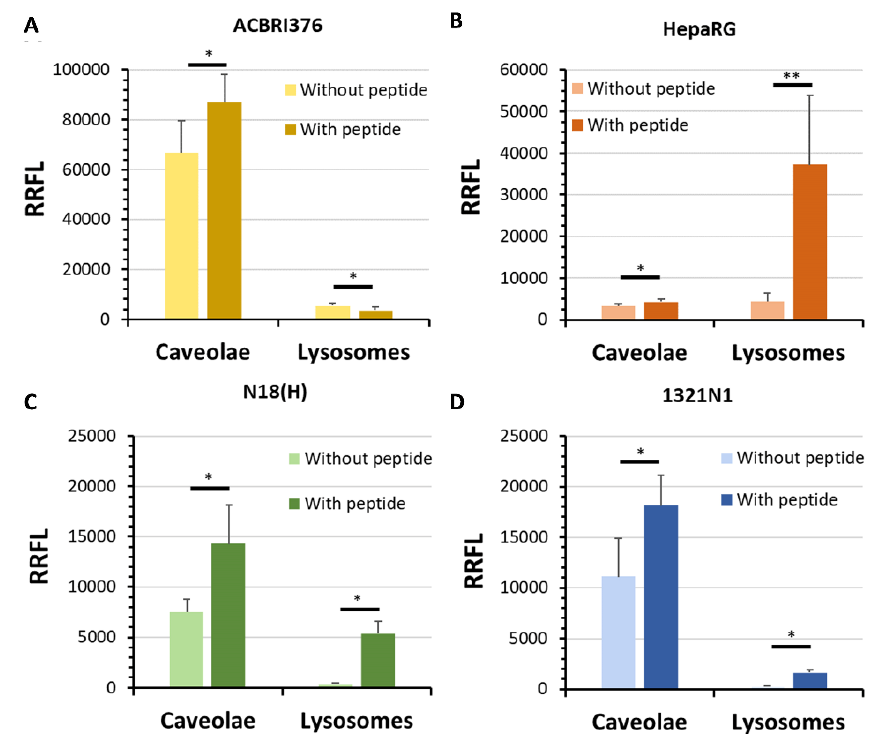
Figure 6. Semi-quantitative analysis of fluorescent labeling of caveolae and lysosomes when ACBRI376 ( A ), HepaRG ( B ), N18(H) ( C ), and 1321N1 ( D ) cells were incubated or not with peptide LRPep2 by the measurement of the RRFL. *: p < 0.05, **: p < 0.001.